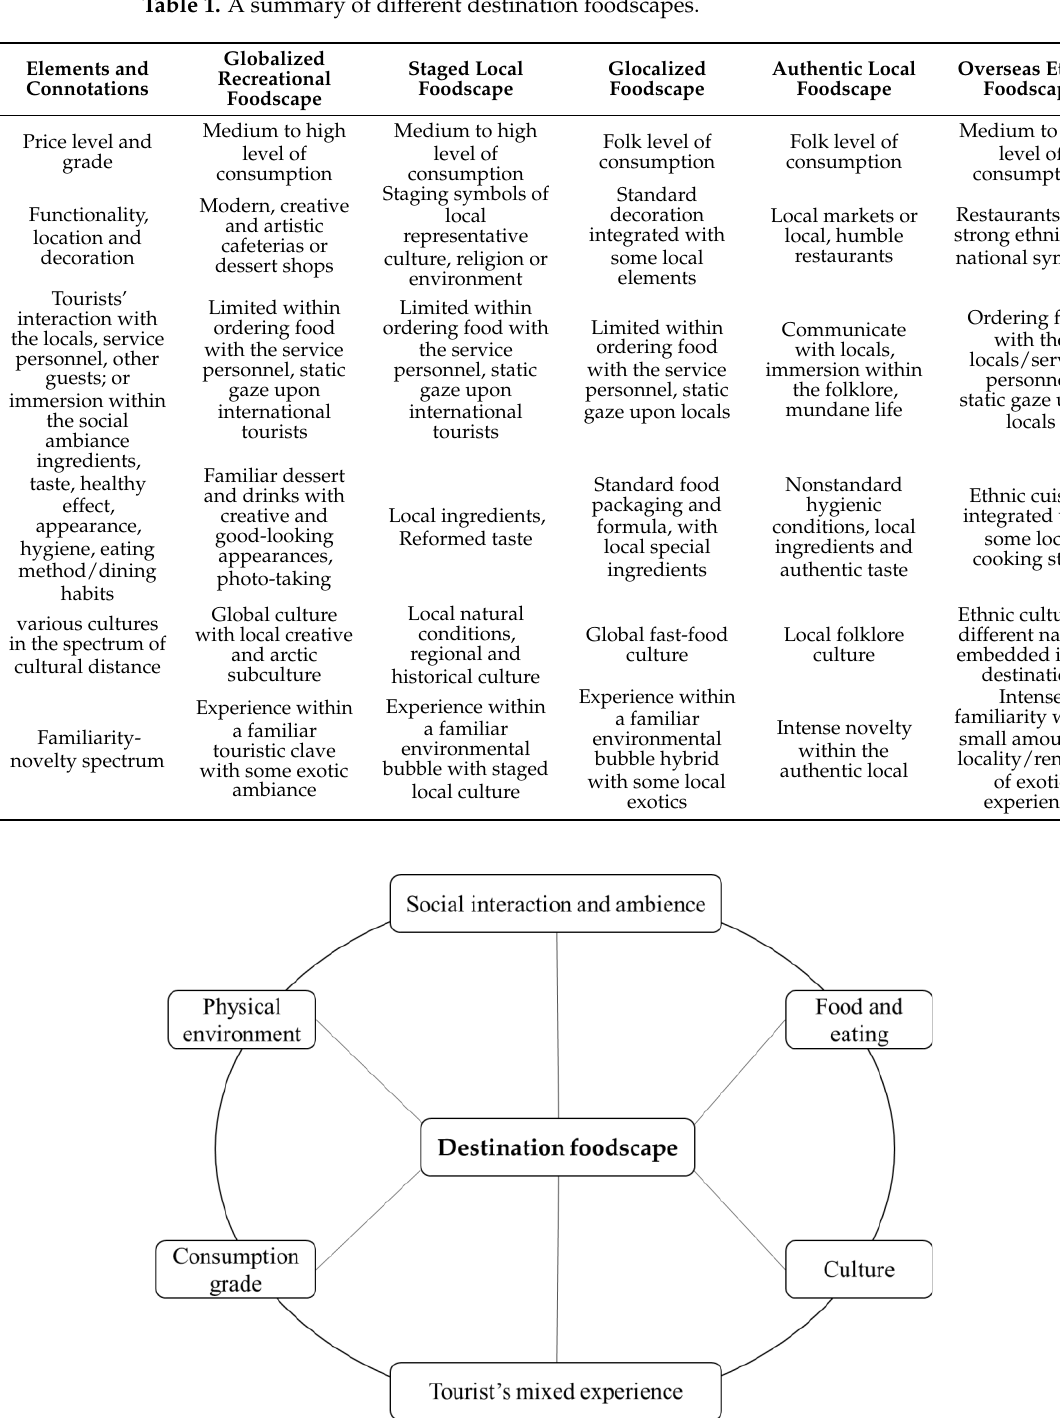
Table 1. A summary of different destination foodscapes.